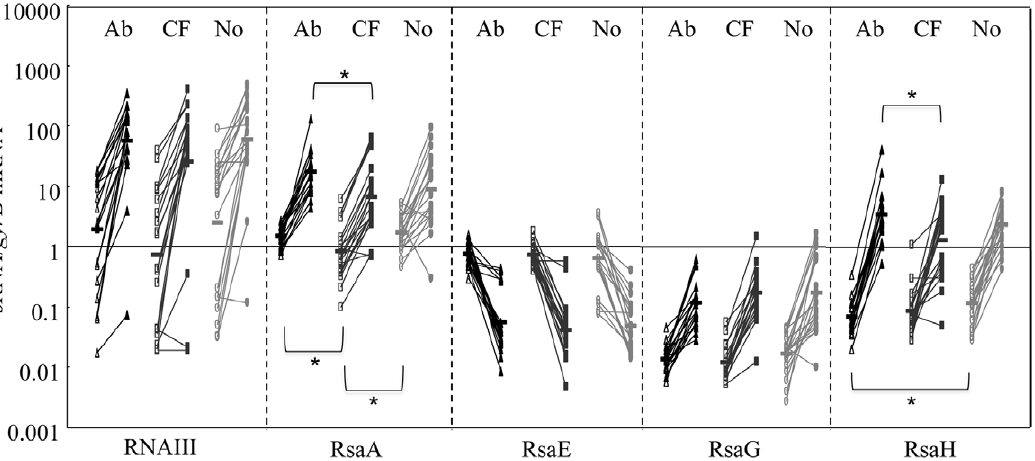
Figure 2. Kinetics of sRNA expression invitro . Clinical S. aureus strains were grown in BH media until mid (OD 550 =0.5) (open triangle) or late- exponential (OD 550 =6) (plain shape) growth phases. Total RNA was extracted, and the sRNA transcripts were quantified by RT-PCR normalized to the level of gyr B mRNA expression. The results are presented according to the isolation sites of the 60 strains: 20 abscesses (Ab), 20 cystic fibrosis sputa (CF) and 20 nasal (No). The results represent the mean of 2 replicate experiments. The bars indicate geometric mean values. *For each sRNA, statistically significant differences (Mann Whitney, p , 0.05) between the level of expression in mid or in late-exponential growth phase and the origin of the isolate are indicated.